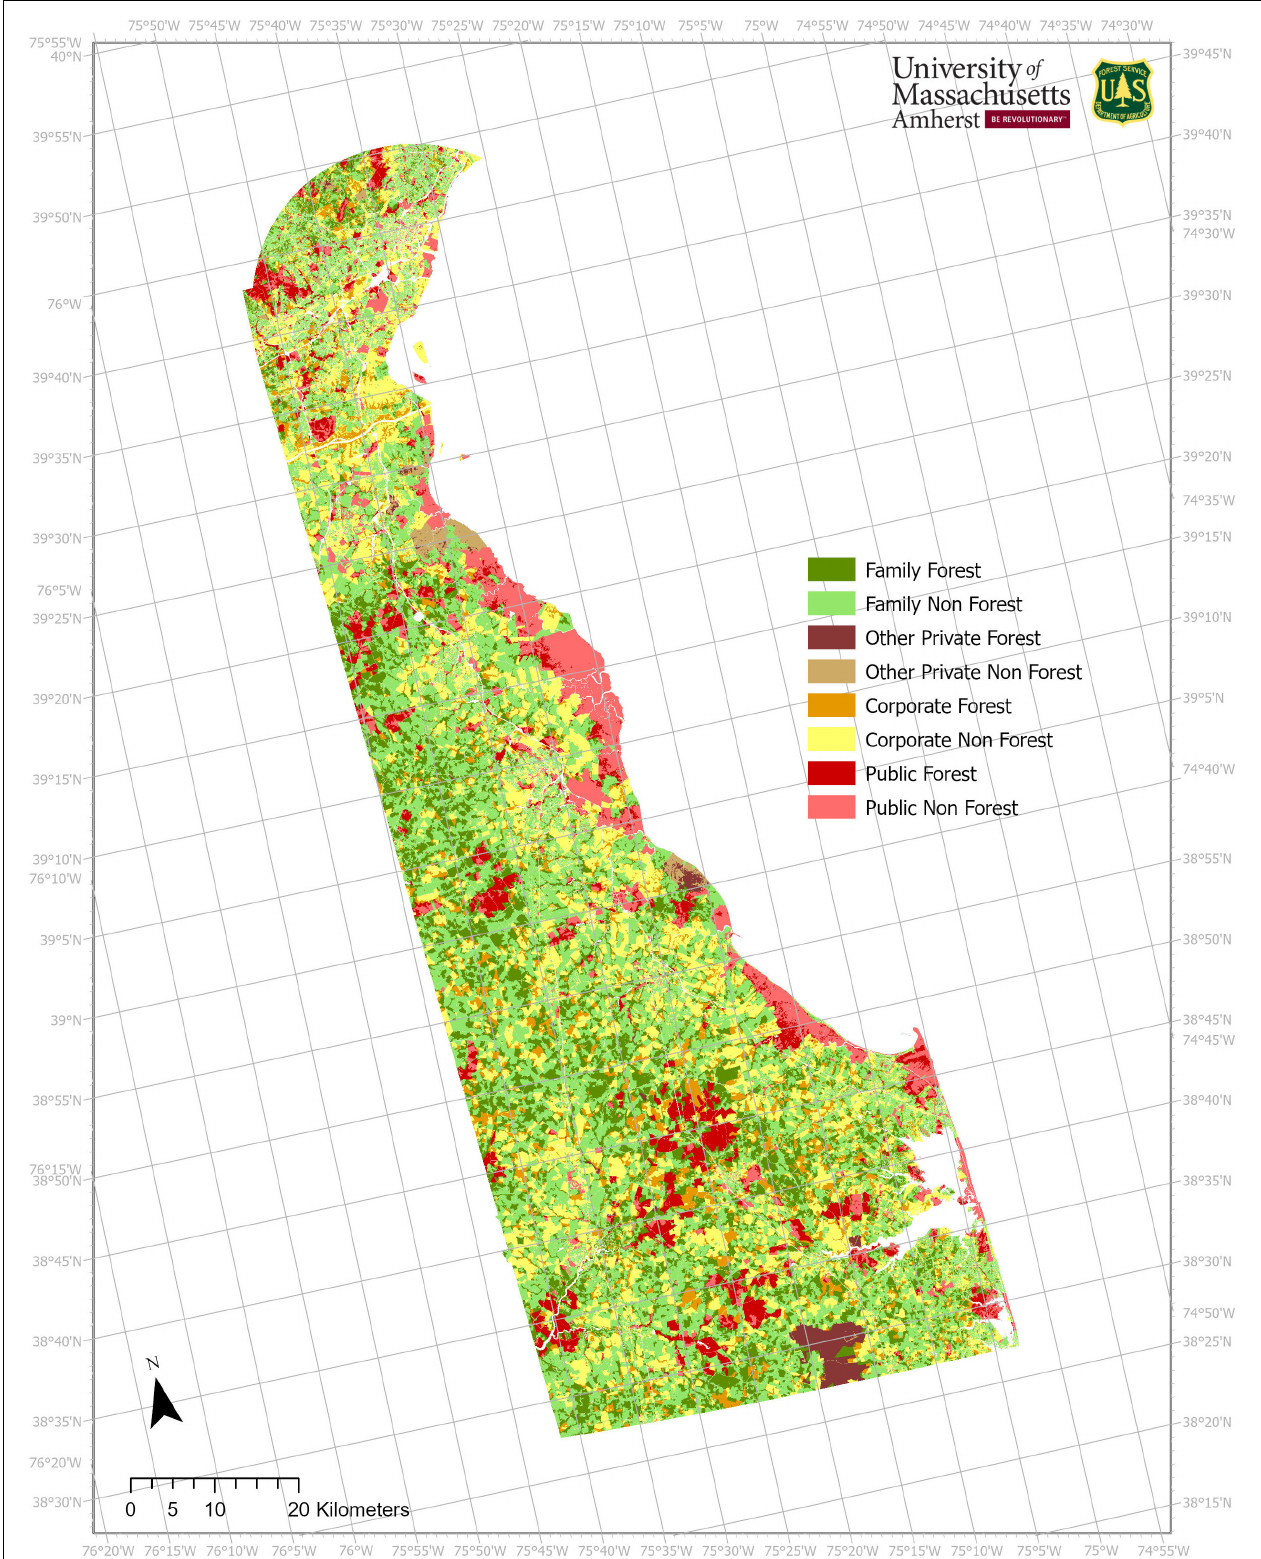
FIGURE 2 | Distribution of ownership classes by forest/non-forest land cover. Delaware, United States, 2020.